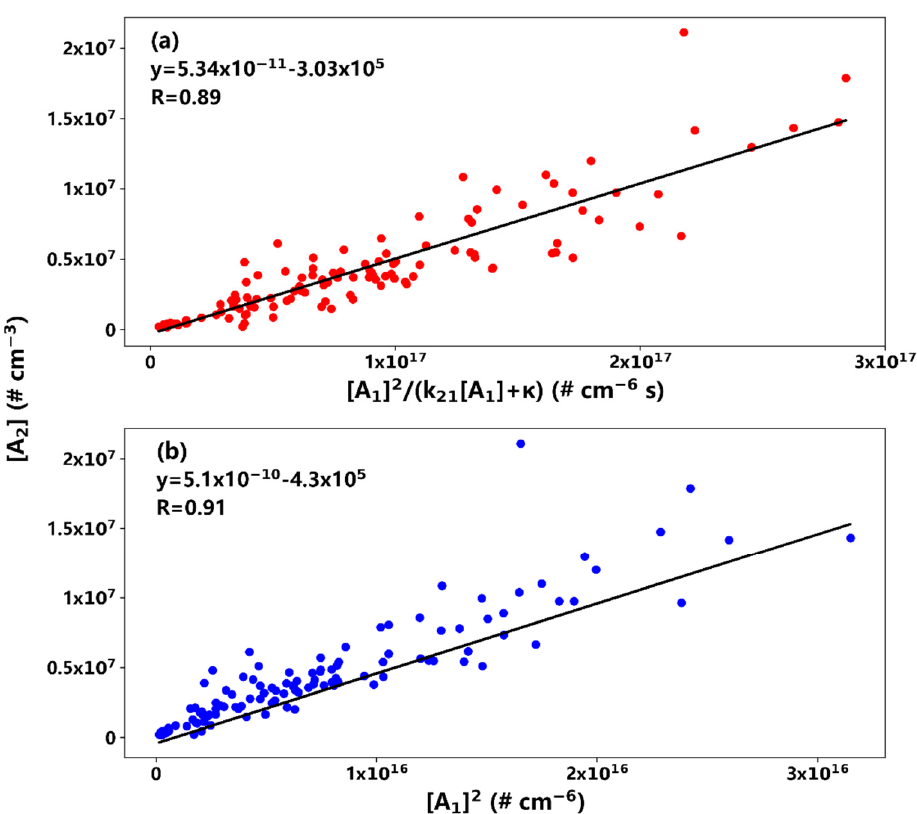
(cid:3118) 2 ( a ) and [ A 1 ] 2 ( b ) during the ( a ) and [A 1 ] 2 ( b ) during k 21 [ A 1 ]+ κ (cid:3038) (cid:3118)(cid:3117) [(cid:3002) (cid:3117) ](cid:2878)(cid:3089)